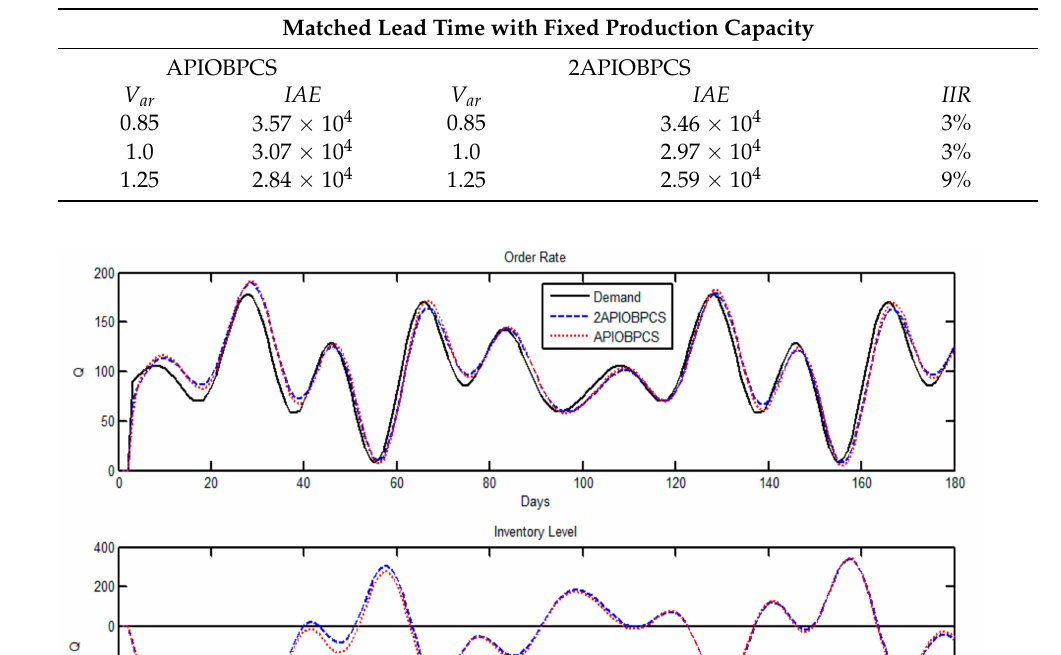
Table 2. Performances of Case 1 (the normal scenario) for the two models.